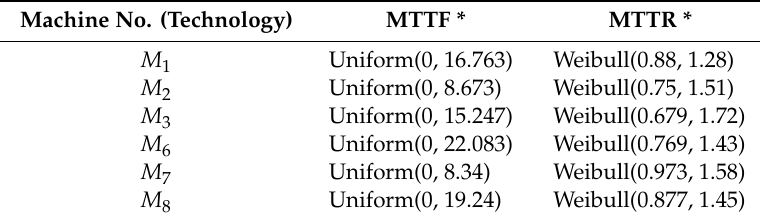
Table 6. Machine failure parameters defined in the simulation environment.